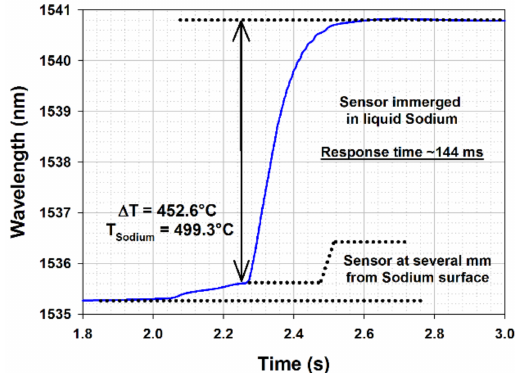
Figure 14. Bragg wavelength increasing during rapid immersion of the regenerated FBG-based temperature probe in sodium (T Penelope = 46.7 ◦ C; T sodium = 499.3 ◦ C).